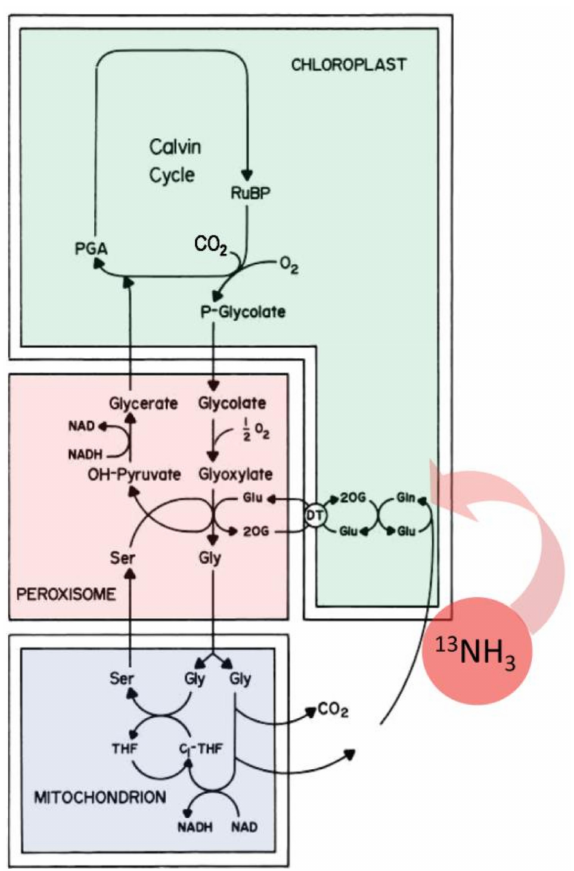
Figure 9. Assimilation of 13 NH 3 gas into the glutamine synthetase—glutamate synthase pathway provides a source of ‘new’ nitrogen in leaf amino acid